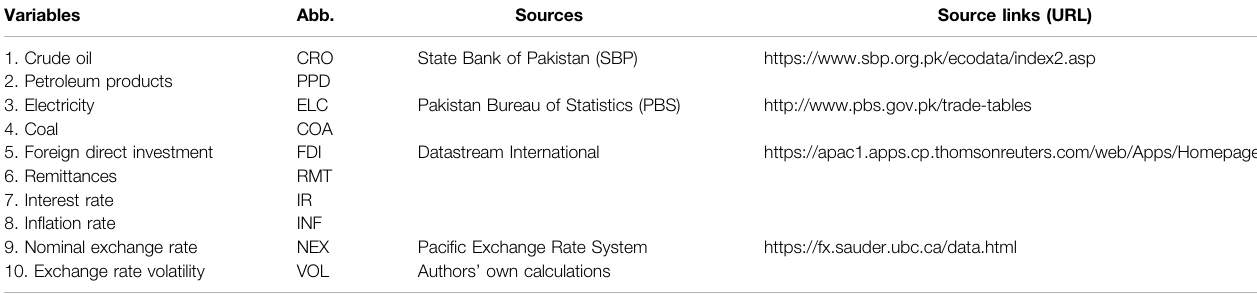
TABLE A1 | Data description and sources.